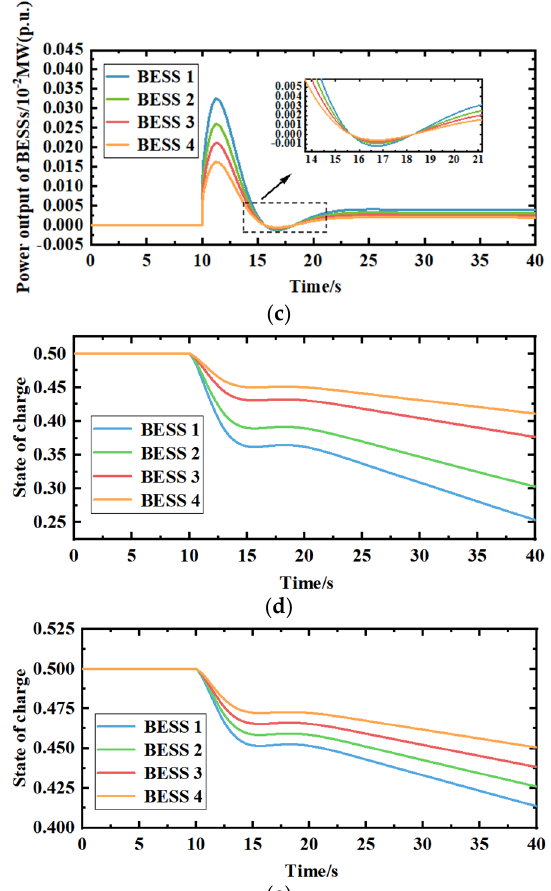
Figure 7. ( a ) Frequency deviation comparison graph; ( b ) the output of BESSs for Scheme 2; ( c ) the output of BESSs for Scheme 3; ( d ) frequency deviation comparison graph; ( e ) frequency deviation comparison graph.